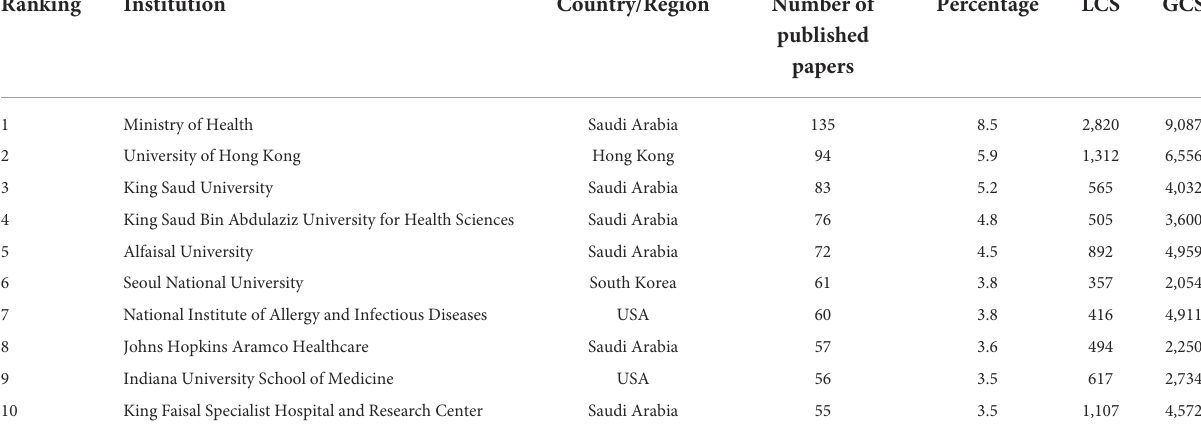
TABLE 7 Top 10 leading institutions in MERS-CoV